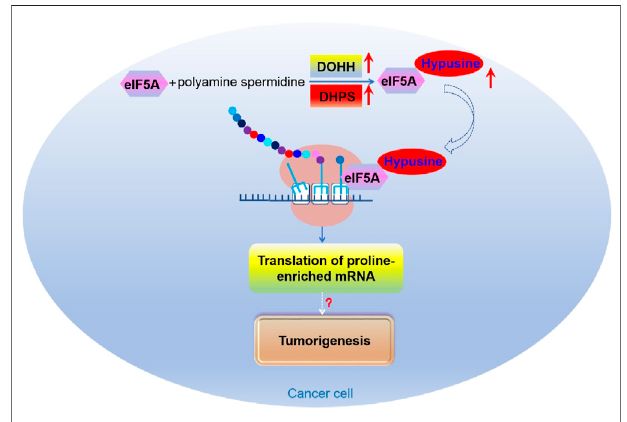
FIGURE 9 | The role of eIF5A mediated translational control in